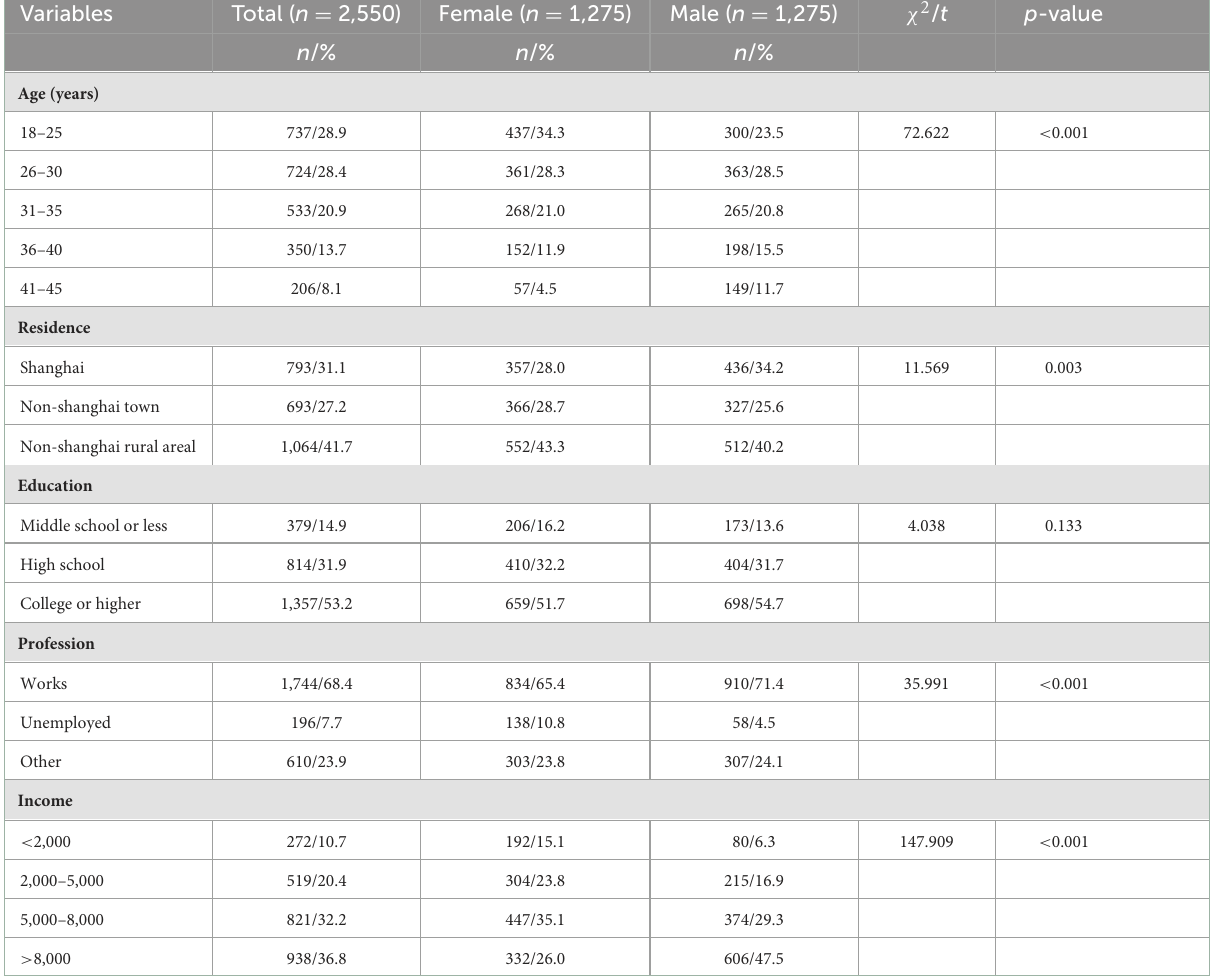
TABLE 1 Sociodemographic characteristics of the participants ( n = 1,275